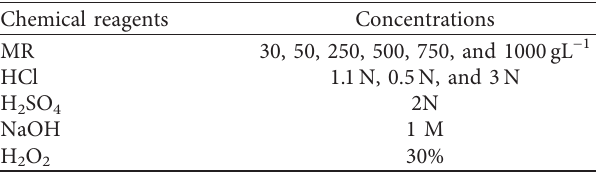
Table 2: Chemical reagents used in experimental essays of ad- sorption of MR